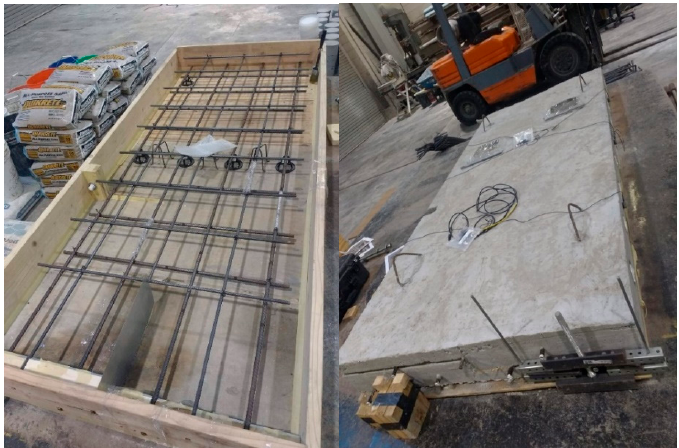
Figure 3. Specimen Set 2 formwork and bars before casting ( left ) and the final specimen ( right ).